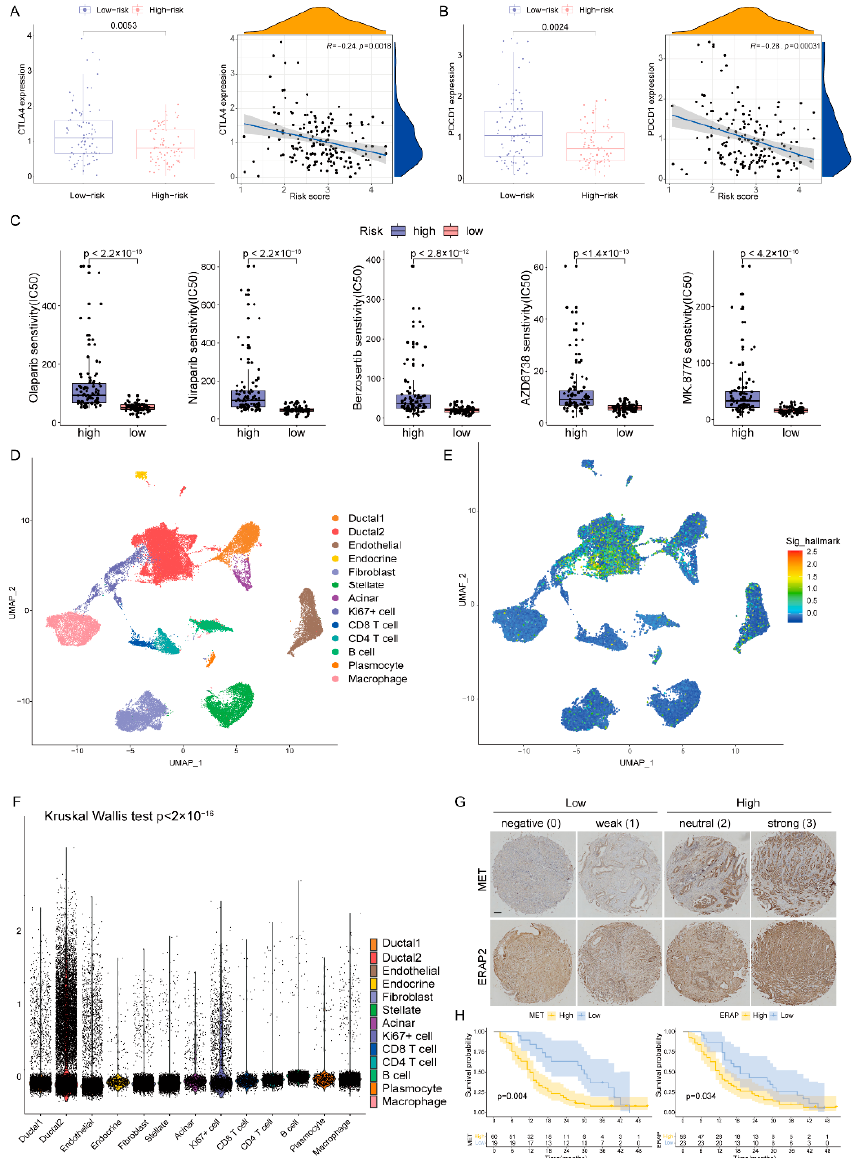
Figure 8. The boxplots and scatter plots of CTLA4 ( A ) and PDCD1 ( B ) in the low ‐ and high ‐ risk groups. ( C ) Boxplots showing estimated IC50 values for Olaparib, Niraparib, Berzosertib, AZD6738 and MK8776 in the TCGA ‐ PAAD dataset ( D ) The uniform manifold approximation and projection (UMAP) plot demonstrates main cell types in PAAD. ( E ) The distribution of each type and DDR ‐ based score expression in PAAD. ( F ) DDR ‐ based scores in different cells are various ( p < 0.05). ( G ) Staining scores of MET and ERAP2 were graded at four levels and two groups. Scale bar, 100 μ m. ( H ) The OS of patients in the high and low expression of MET or ERAP2.